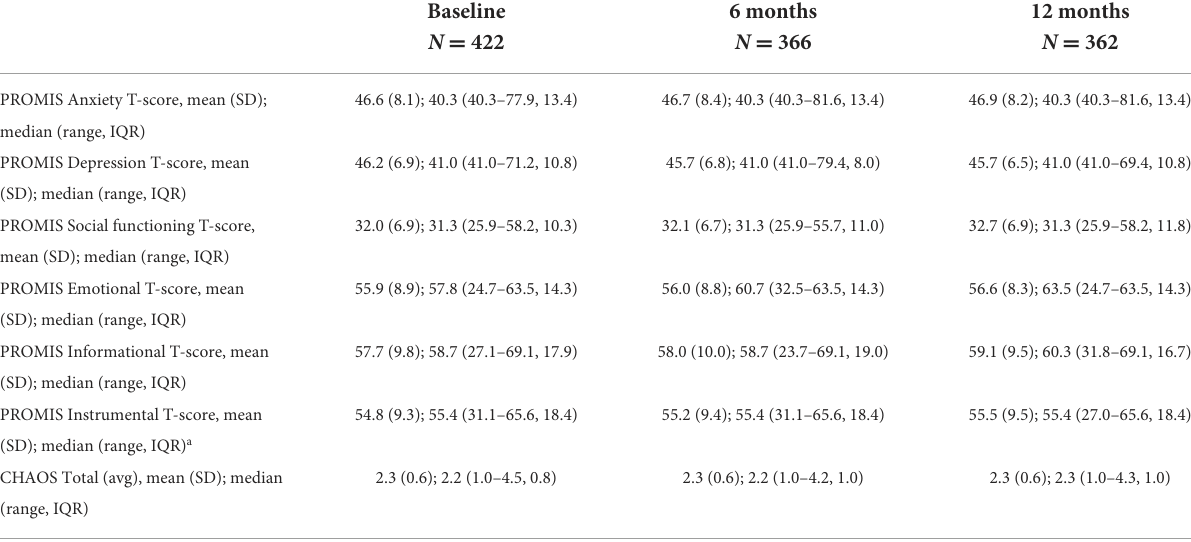
TABLE 2 Caregiver and household psychosocial stress levels over time.